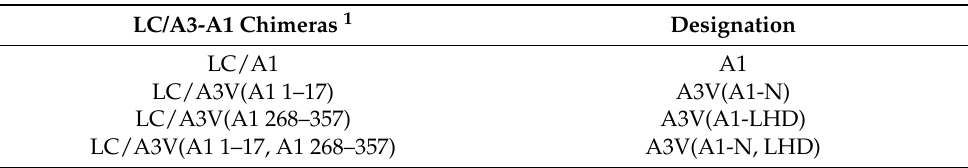
Table 1. EGFP-LC/A3-A1 chimeras analyzed in this